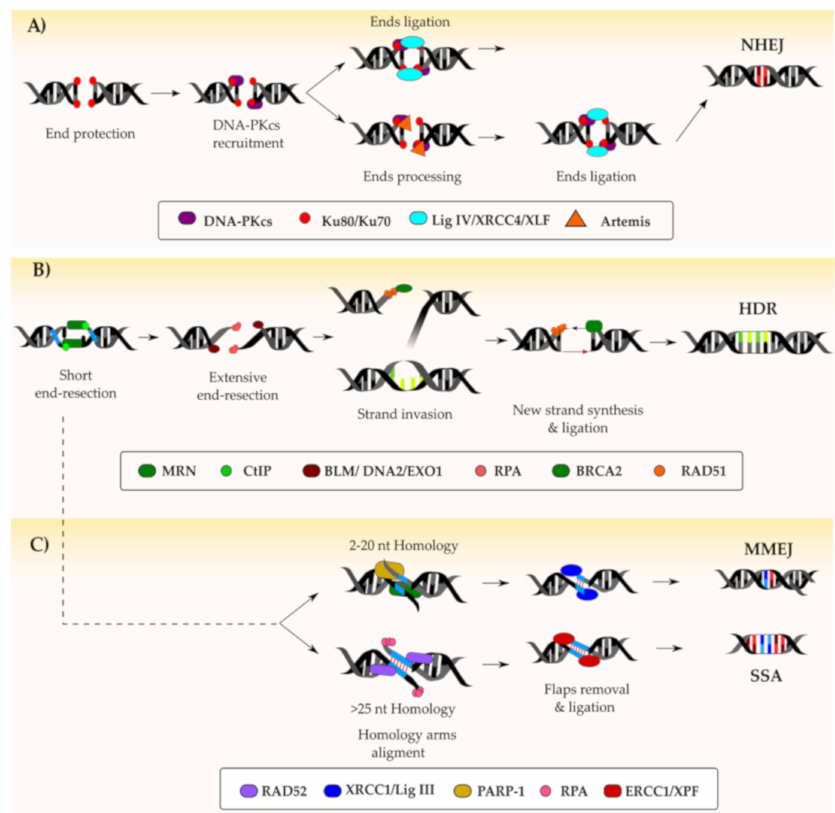
Figure 2. Resolution of a DNA double-stranded break (DSB): Following the recognition and marking of a DSB by the concerted action of key proteins such as ATM (ataxia-telangiectasia mutated), ATR (ataxia telangiectasia and Rad3-related) and DNA-PKcs (DNA-dependent protein kinase catalytic subunit), the repair can follow di ff erent pathways. On one hand, if the DNA ends are protected by the Ku70 / Ku80 complex, the DSB is generally repaired via the non-homologous end-joining (NHEJ) pathway (depicted in A ). In this case, an intermediate end-processing step might be necessary if the protected ends are not compatible. On the other hand, resection of the DNA ends by the MRN / CtIP (MRE11-RAD50-NBS1 / C-terminal-binding protein interacting protein) complex results in NHEJ inhibition. Based on the length of homology DNA fragments revealed during end-resection, the DSB can be repaired either via homology-directed repair (HDR) ( B ) or microhomology-mediated end joining (MMEJ) / single-strand annealing (SSA) ( C ). The key factors involved in the DNA repair pathways depicted are indicated within the